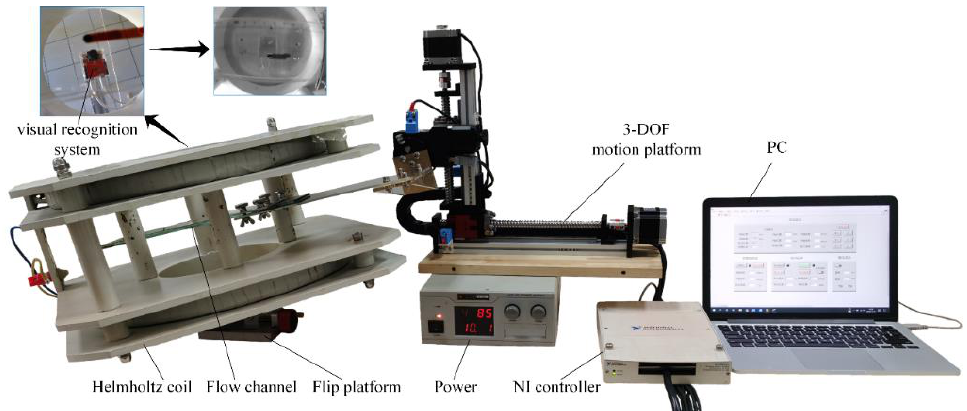
Figure 1. Components of the novel measuring system. The 3-DOF motion platform includes an X -axis movement, a Y -axis movement, and a Z -axis rotation, which are driven by stepping motors. To improve the measurement accuracy, a small absolute encoder is installed inside the motor. The flow channel is composed of two transparent polytetrafluoroethylene (PTFE) plates, separated by a gap- adjustment gasket. Selecting different gaskets with different thicknesses leads to the adjustment of the gap according to the viscosity of the measuring sample. The flow channel is fixed on the Z -axis of the 3-DOF motion platform, which passes through the center of the Helmholtz coil. The magnetic field is generated by the Helmholtz coils, which are composed of a pair of identical, coaxial, and parallel closely wound current coils with 2000 turns. The maximum central magnetic field reaches 24 kA/m. A laser displacement sensor is installed at the bottom of the Helmholtz coil to detect the position of the flow channel in the vertical direction inside the Helmholtz coil. The turning platform is used for the rotation of the Helmholtz coil, which can be rotated with the change of the angle of the flowing